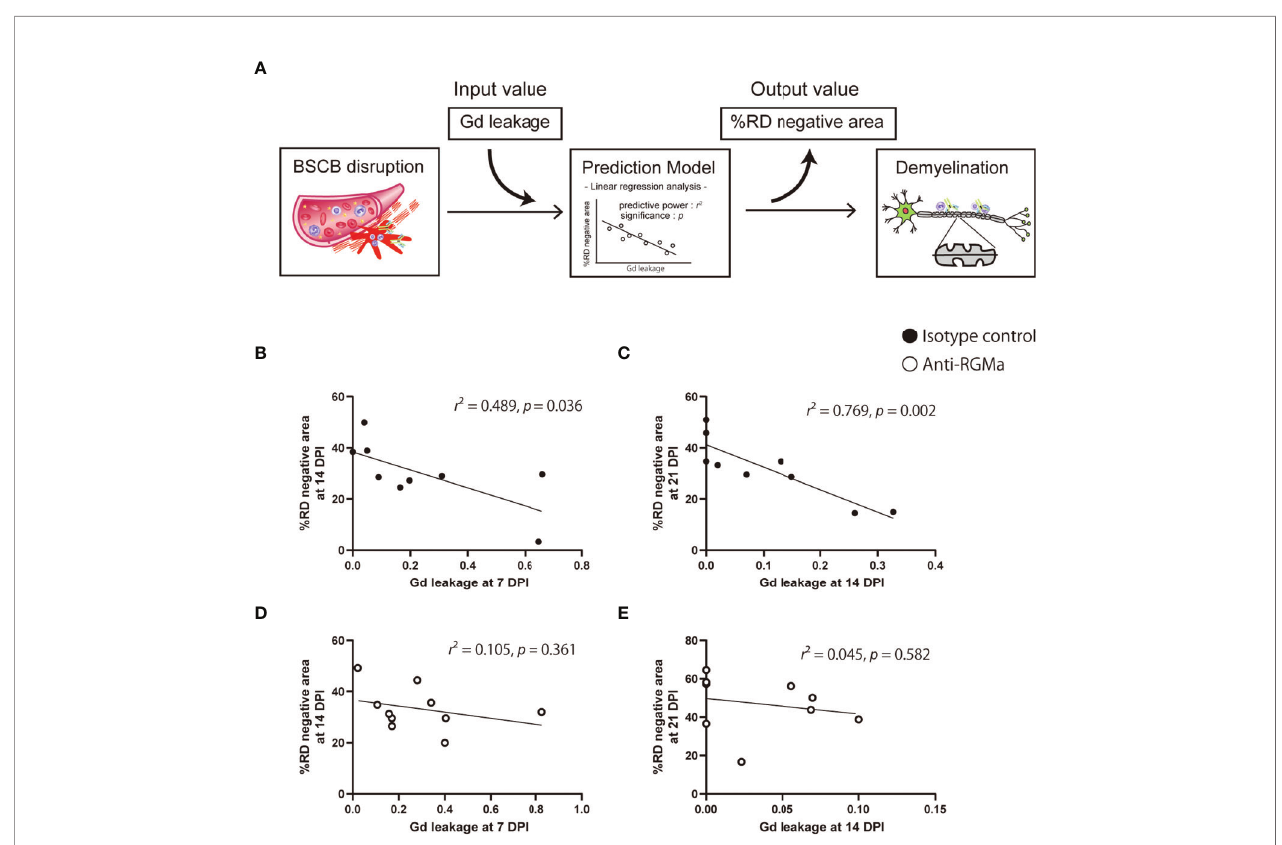
FIGURE 4 | Prediction of myelin integrity based on BSCB disruption. (A) The prediction approach based on an input-output model with linear regression analysis. (B – E) Each plot shows the extent of Gd leakage and %RD negative area at 7 days in the isotype control group (B, C) and anti-RGMa group (D, E) . The effect size ( r 2 ) of linear regression analysis and p -values are also shown.